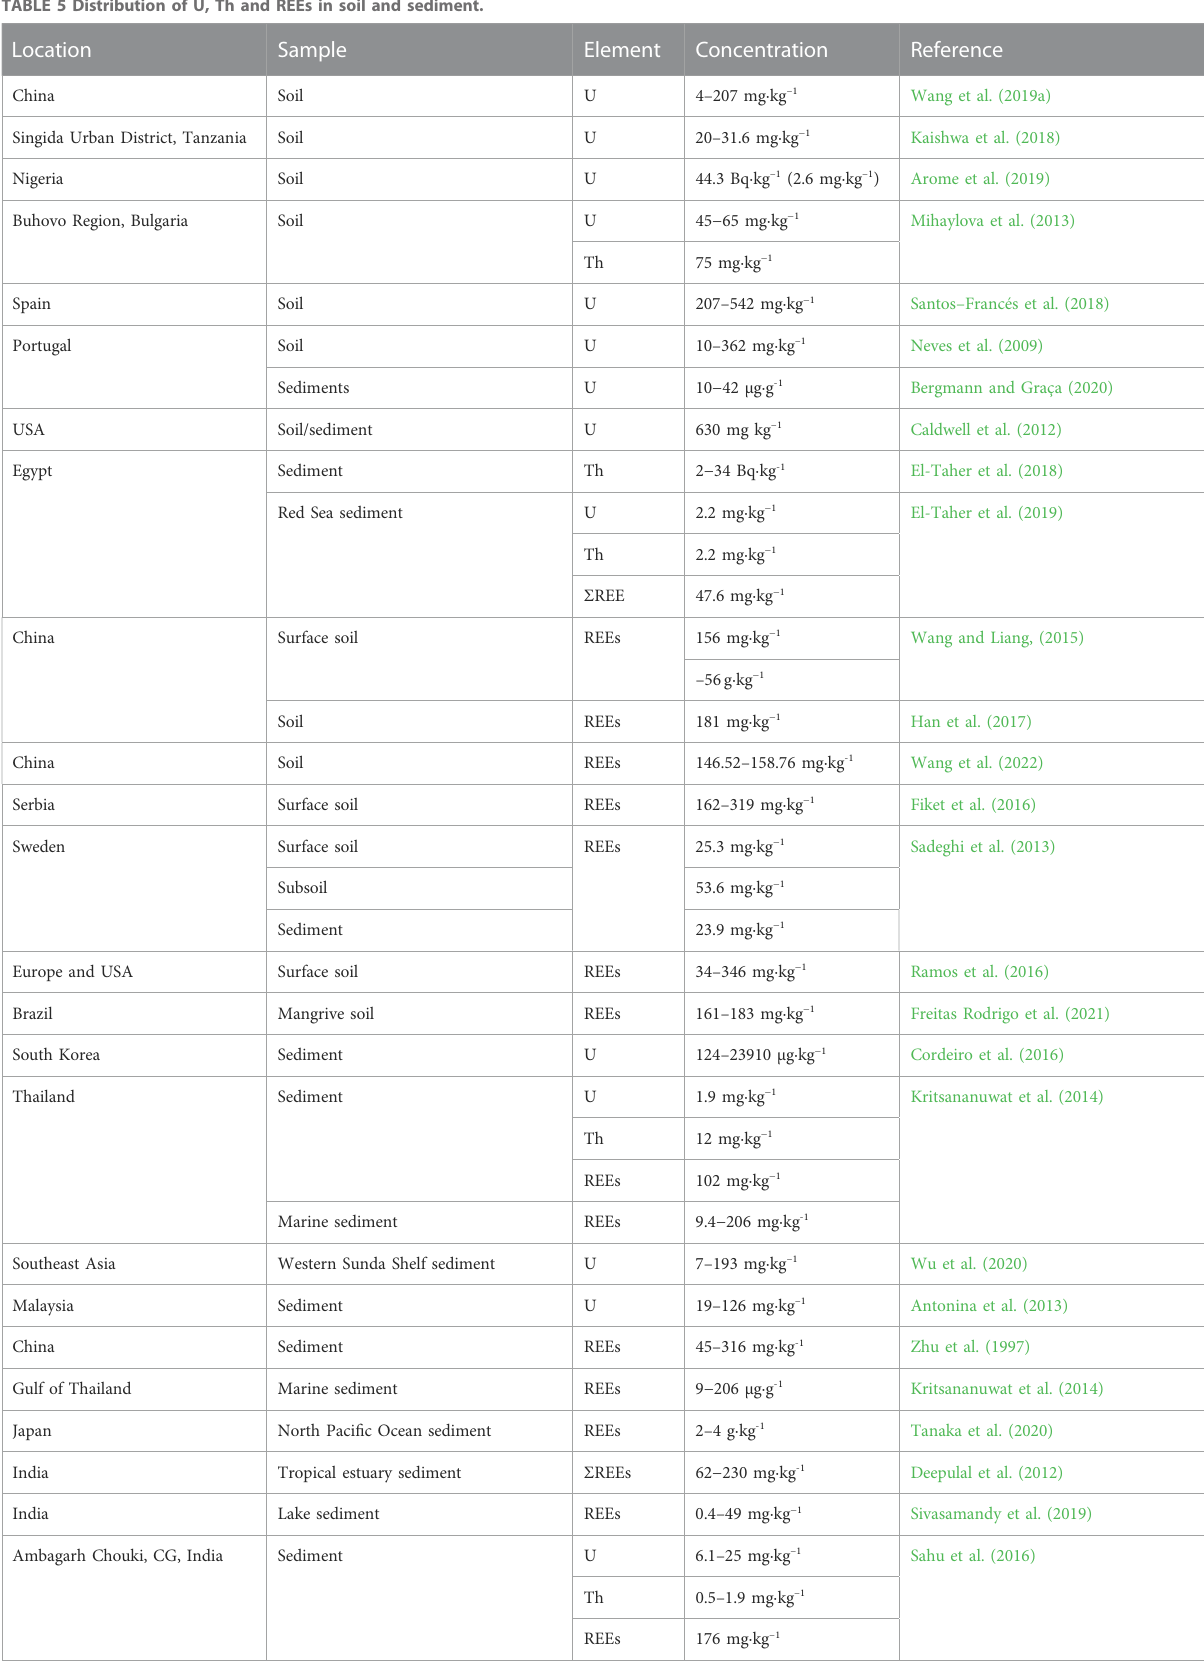
TABLE 5 Distribution of U, Th and REEs in soil and